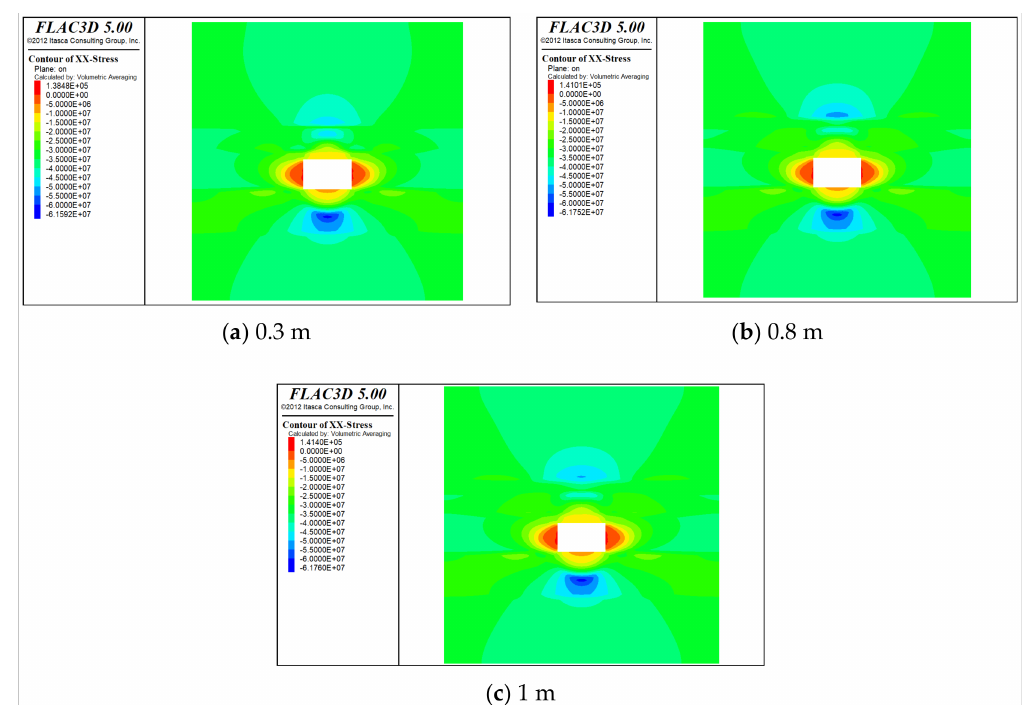
Figure 10. Horizontal stress nephograms of roadway surrounding rock.